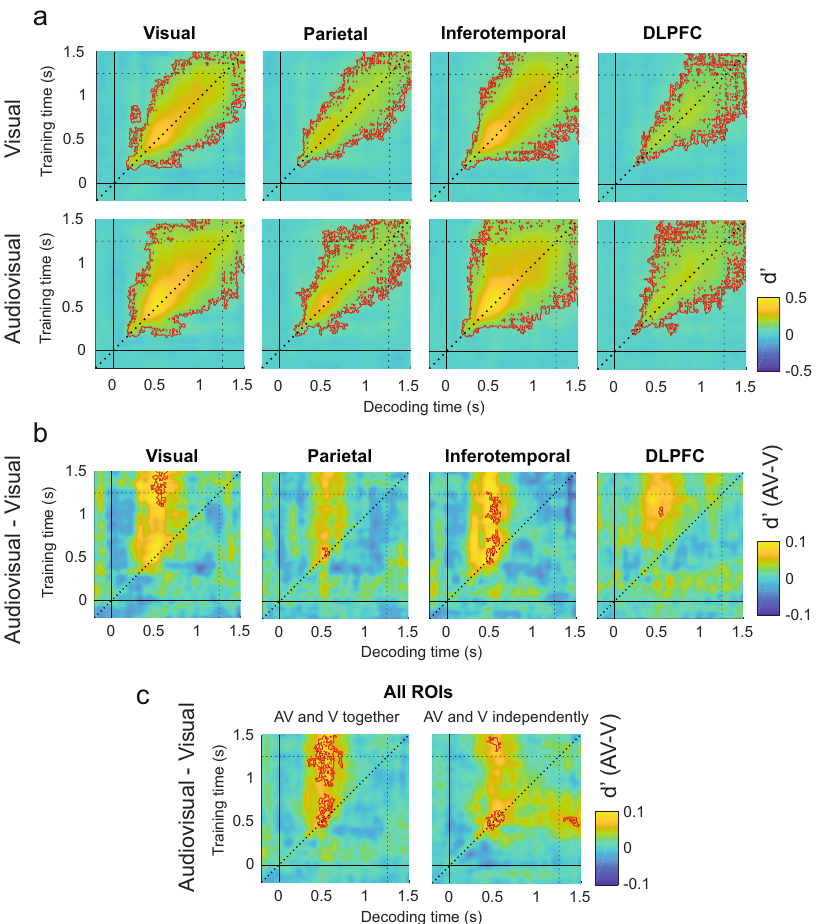
Fig. 4 Visual sensitivity decoded from visual and audiovisual stimuli across ROIs. Temporal generalization matrixes depict ( a ) the neural decoder ’ s sensitivity parameter (d ′ ) in the visual (upper TGMs) and audiovisual (bottom TGMs) conditions and their difference ( b ) in each ROI. c Represents the differential decoded sensitivity averaged over ROIs with classi fi ers trained in the visual and audiovisual conditions together (left panel) or separately (right panel). Independently trained classi fi ers replicate similar results as when the classi fi ers were trained in both conditions together and recovers the expected decoding symmetry with respect to the diagonal. Red contours delimit signi fi cant clusters. Vertical and horizontal dotted lines represent the response phase